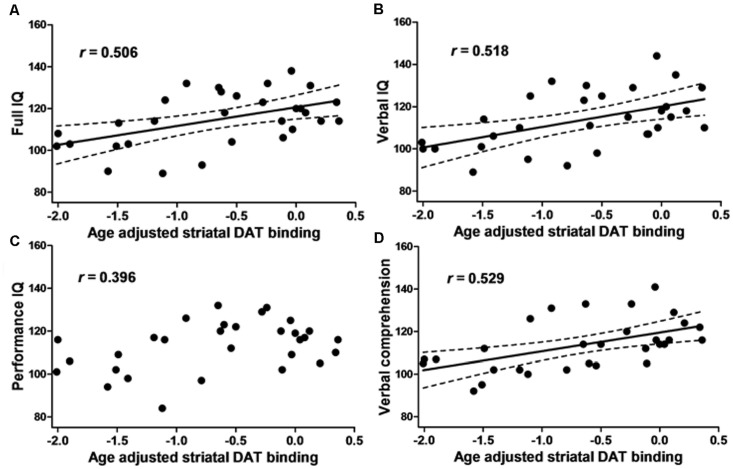
The relationship between the intelligence quotient (IQ) and dopamine transporter (DAT) binding. The scatter plot showing the age-adjusted intellectual score and age-adjusted right and left averaged striatal specific binding ratio (SBR) of [123I]-FP-CIT SPECT in 30 healthy subjects. (A) The full IQ, (B) Verbal IQ (VIQ) and (D) verbal comprehension were positively correlated with the striatal DAT binding. (C) Performance IQ (PIQ), working memory, perceptual organization and processing speed (see text) did not show any correlation. The dotted line represents the 95% confidence interval.